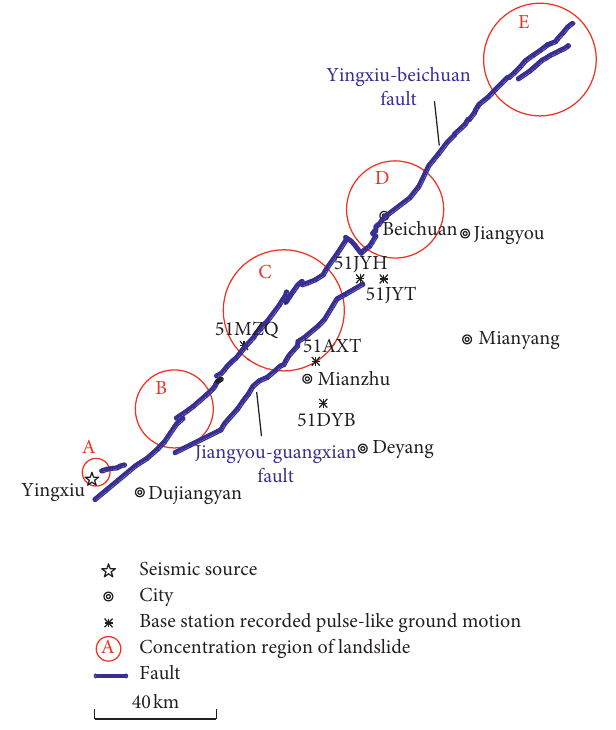
Figure 3: Distribution of near-fault pulse-like ground motion records and large-scale landslides in Wenchuan earthquake [9, 10]. Earthquake (Wen et al., 2010; Xu et al., 2009)